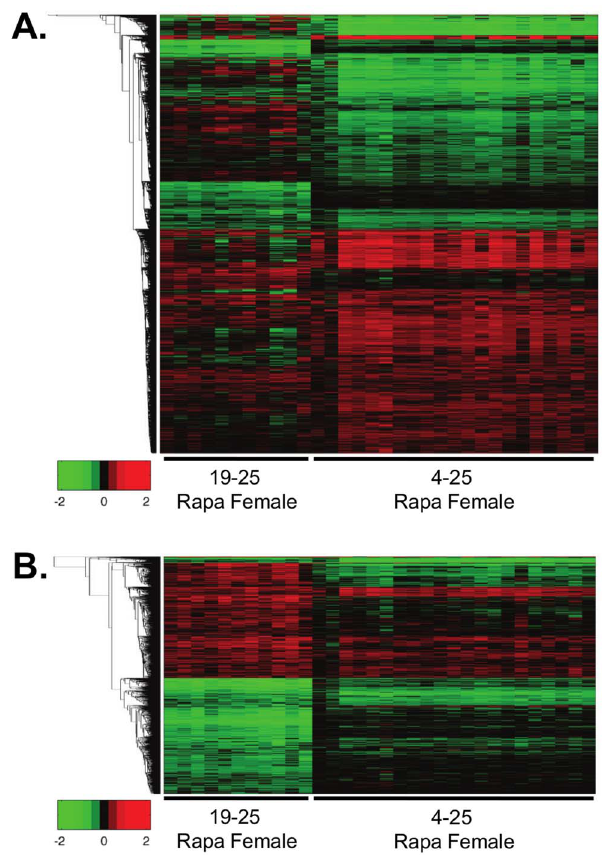
Figure 7. Relative heatmap analysis indicates high degree of similarity between 6-months and chronic Rapa feeding in female mice. Heatmap analysis of individual, 25-month-old female mice fed Rapa for 6 (6-months) or 21 (chronic) months compared to the respective average of the control females are shown. The transcripts that are significantly changed in 6-months or chronic Rapa females are shown in ( A ) and the transcripts that only significantly change in 6- months Rapa females are shown in ( B ) compared to chronic Rapa females. For this heatmap analysis, red indicates up-regulated transcripts, green indicates down-regulated transcripts, and black indicates little or no change. The transcripts were plotted using log2 values and the heatmap scales from a change of 2 2 to 2 log2 change. A list comparing the transcripts that significantly changed with 6-months or chronic Rapa feeding is shown in the same top to bottom clustering order as the heatmap in File S2, tab6.